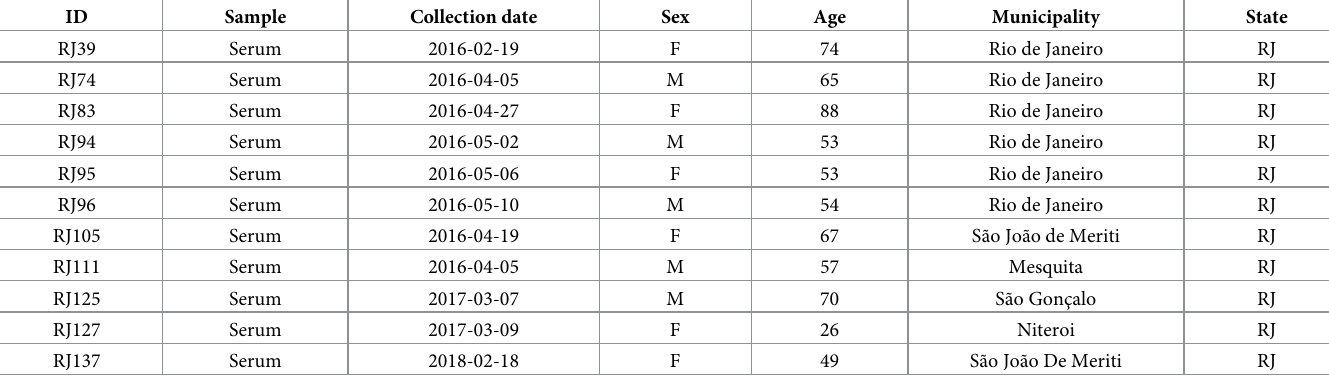
Table 1. Epidemiological data for the sequenced